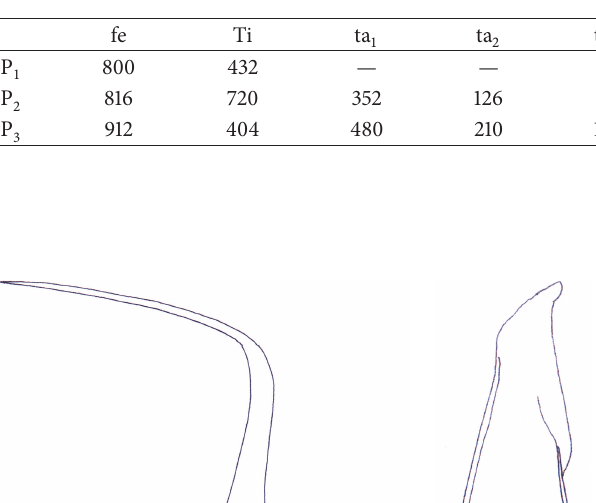
Table 3: Lengths ( 𝜇 m) and proportions of leg segments.